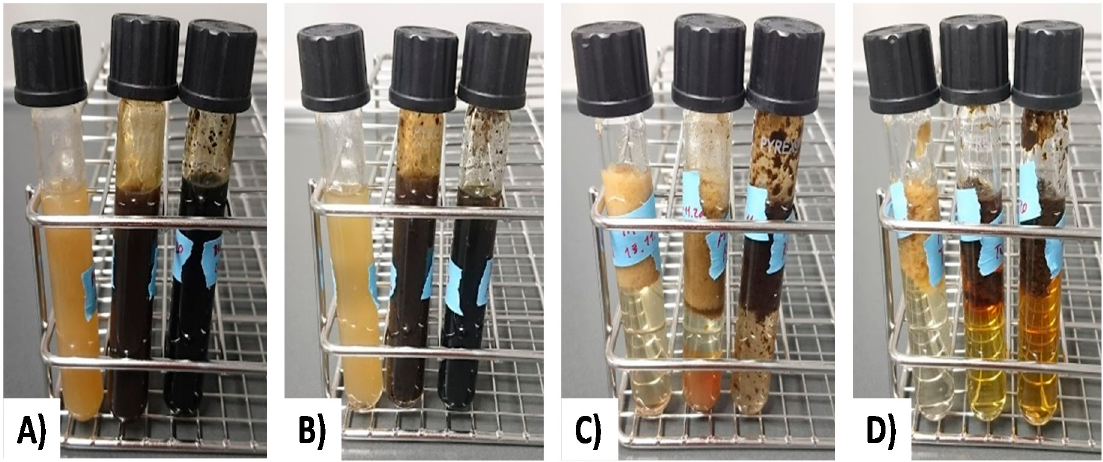
Figure 15. Pyrolysis condensate in the solvents ( A ) ethyldecanoate; ( B ) hexadecane; and water supplemented with each 10% of the emulsifiers; ( C ) rhamnolipids and ( D ) Tween80 (Picture: Kristina Bitter).